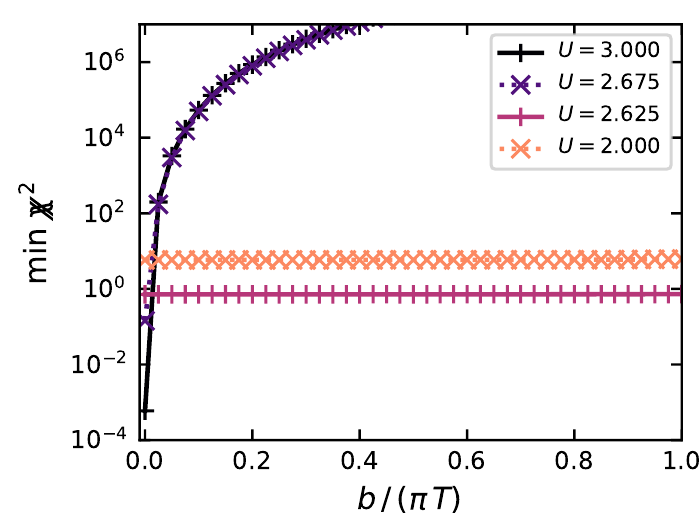
Figure 3: Minimum values of the fit loss as a function of the blur parameter b for different interaction values and T = 1 / 200. A strong(very weak) dependence of this quantity as a function of b is a reliably rigorous marker for the presence(absence) of an anomalous term in the response